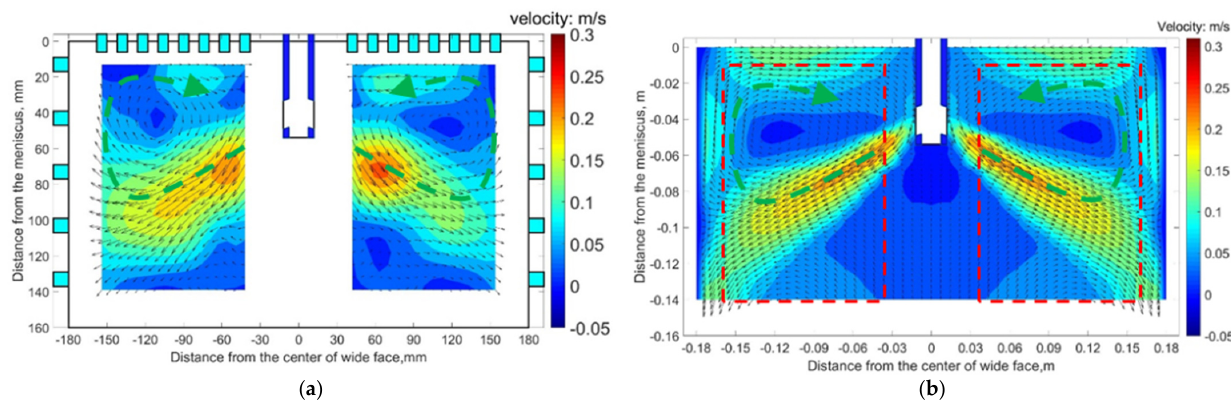
Figure 4. Vector and contour of fluid flow obtained at quarter plane of mold fixed side under the condition of 1.2 m/min-0 A: ( a ) physical model and ( b ) numerical model.